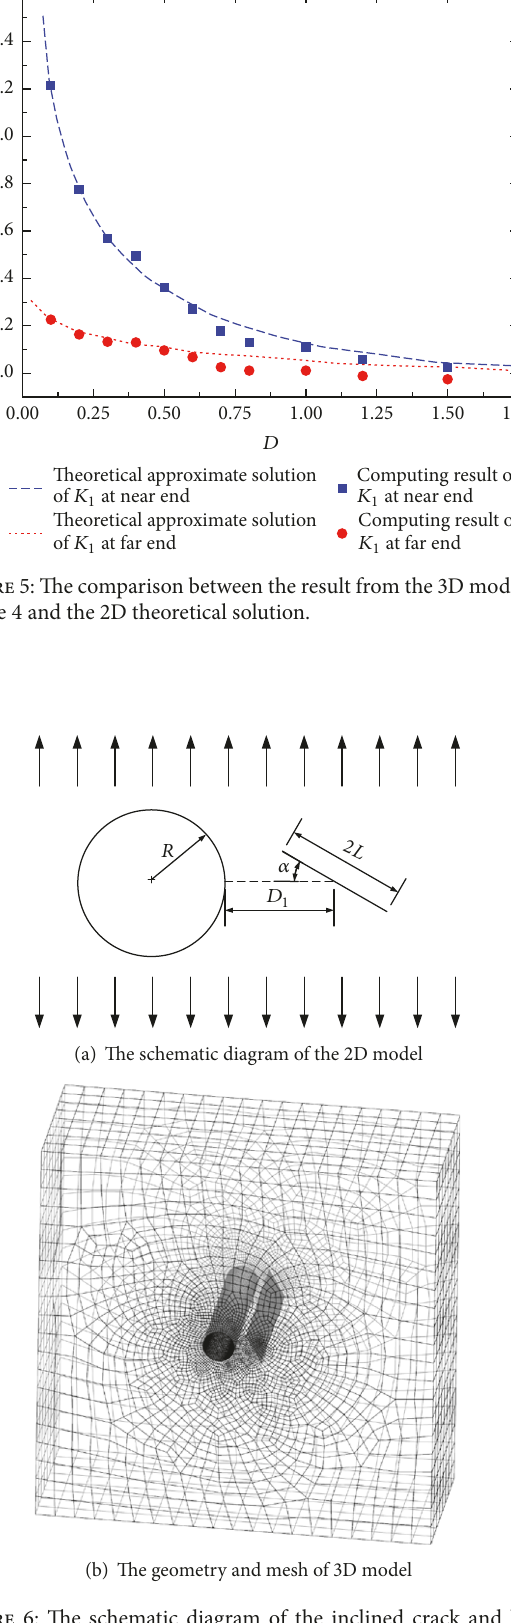
Figure 6: The schematic diagram of the inclined crack and hole model.